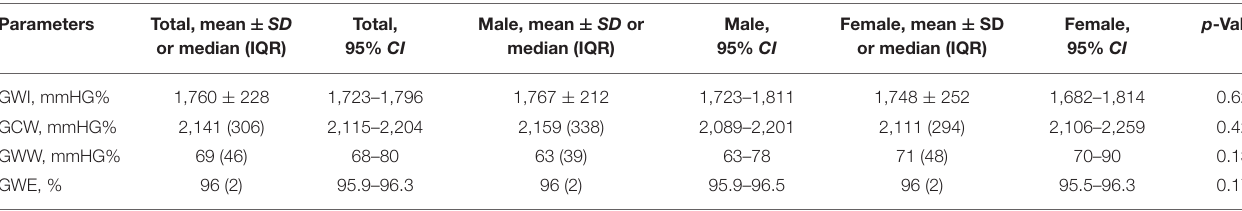
TABLE 2 | Myocardial work non-invasive